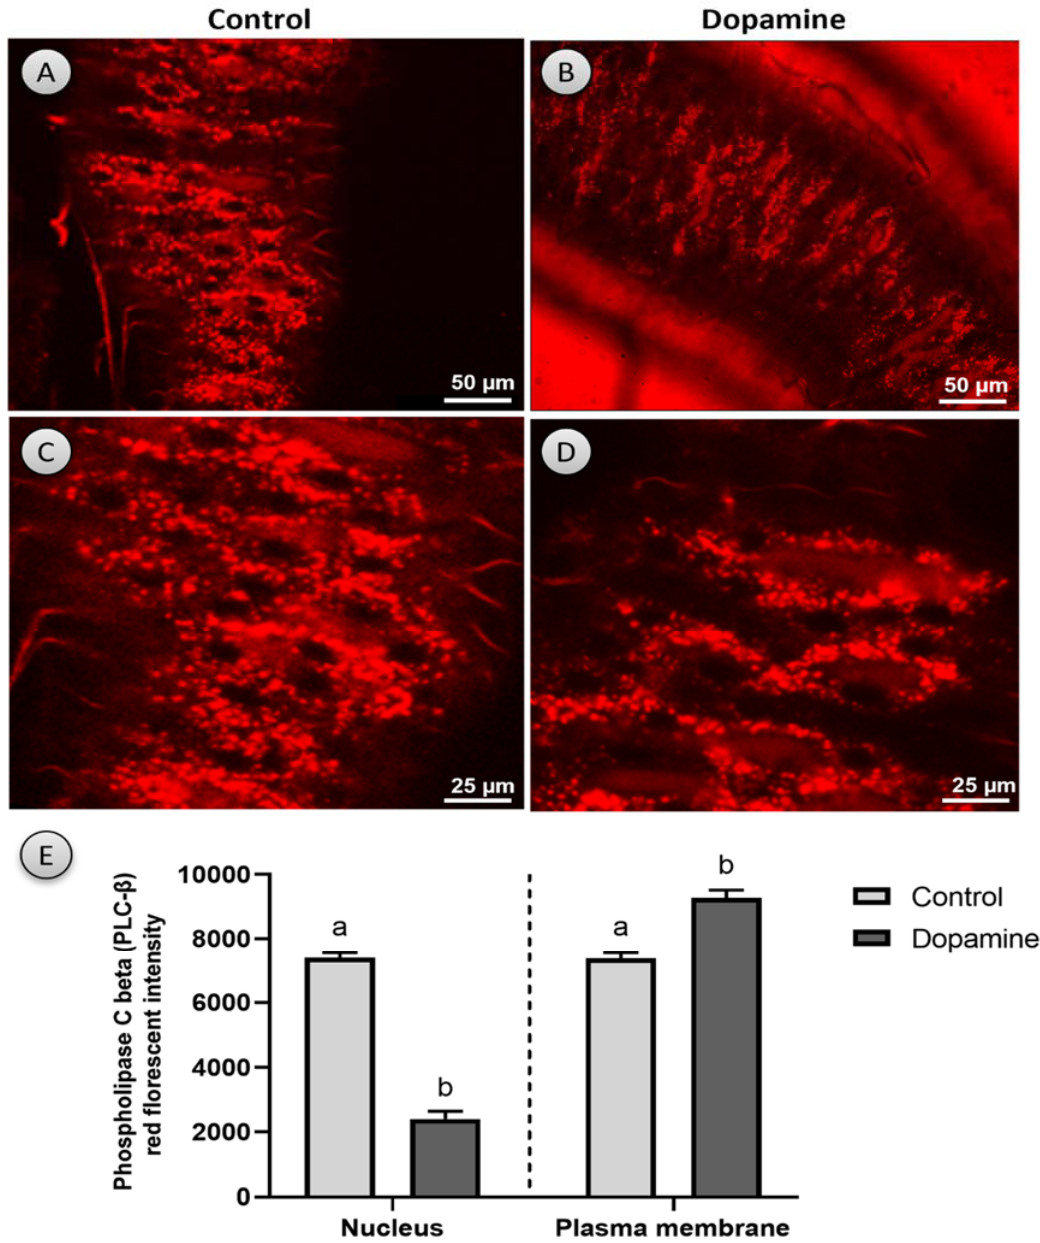
Figure 7. Phospholipase C beta (PLC- β ) translocation in enterocytes cells of the gut of F1 flies ( n = 10) results from the crossing of UAS-PLC-mRFP with NP1-GAL4 in the control ( A , C ) and after dopamine 10 − 3 M application. ( B , D , E ) Quantification of PLC-red fluorescence localization in the nucleus and cell membrane in the control and after dopamine application; dopamine activates the translocation of PLC- from the cytoplasm to the plasma membrane in enterocyte stem cells more quickly than a control. Column bars with different lowercase letters denote significant differences among treatments (Student’s t -test, p < 0.05).